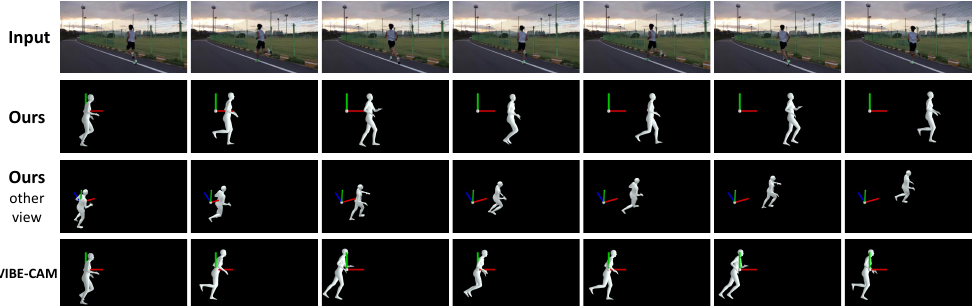
Figure 1. Given a runner video (first row), the proposed framework correctly reconstructs 3D running path (second and third rows), while VIBE-CAM, the combination of state-of-the-art human pose estimation methods [11,16,17], fails to reconstruct the 3D global pose of the runner (fourth row). The global pose represents the orientation and location of the entire body. The visualized reference frame is defined as being aligned with the person in the first frame. VIBE-CAM is detailed in Section 4.5.